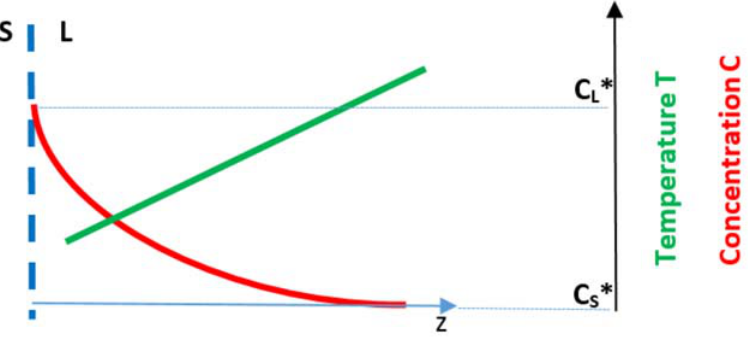
Figure 9. Schematic diagram showing concentration and temperature gradients ahead of an S/L interface.